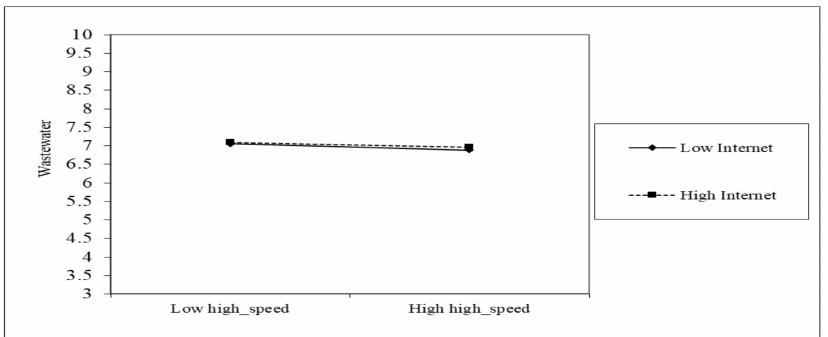
Figure 5. The moderating effect of Internet